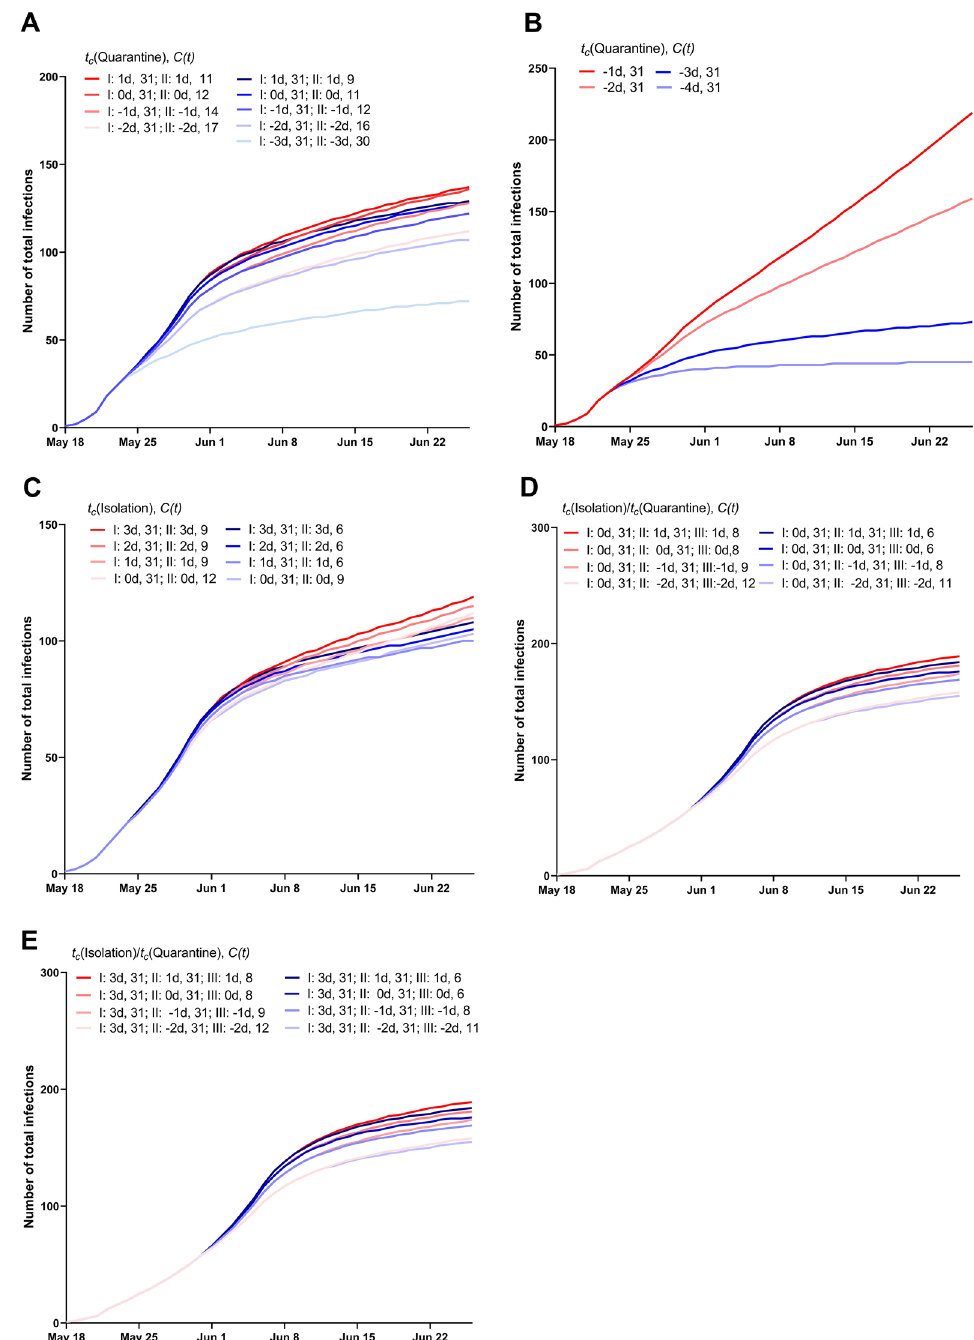
Figure 6. Estimation of effectiveness of the four strategies. ( A ) Strategy 1: initial quarantine/isolation followed by social distancing, including two phases. The first phase is from May 21 to May 28: t c (Quarantine) = − 4d, − 3d, − 2d, − 1d, 0d, 1d, C(T) = 31; The second phase is from May 28 to June 26: t c (Quarantine) = − 4d, − 3d, − 2d, − 1d, 0d, 1d, C(T) = 31*(5–95%); ( B ) Strategy 2: quarantine/isolation only from May 21 to June 26: t c (Quarantine) = − 4d, − 3d, − 2d, − 1d, 0d, 1d, C(T) = 31; ( C ) Strategy 3: initial isolation followed by social distancing, including two phases. The first phase is from May 21 to May 28: t c (Isolation) = 0d, 1d, 2d, 3d, C(T) = 31; The second phase is from May 28 to June 26: t c (Isolation) = 0d, 1d, 2d, 3d, C(T) = 31*(5–95%); ( D ) Strategy 4: initial isolation followed by quarantine and social distancing. The isolation was initially implemented the same day of symptom onset, including three phases. The first phase is from May 21 to May 28: t c (Isolation) = 0d, C(T) = 31; The second phase is from May 28 to June 5: t c (Quarantine) = − 4d, − 3d, − 2d, − 1d, 0d, 1d, C(T) = 31; The third phase is from June 5 to June 26: t c (Quarantine) = − 4d, − 3d, − 2d, − 1d, 0d, 1d, C(T) = 31*(5–95%); ( E ) Strategy 4: initial isolation followed by quarantine and social distancing. The isolation was initially imposed on average 3 days after symptom onset, including three phases. The first phase is from May 21 to May 28: t c (Isolation) = 3d, C(T) = 31; The second phase is from May 28 to June 5: t c (Quarantine) = − 4d, − 3d, − 2d, − 1d, 0d, 1d, C(T) = 31; The third phase is from June 5 to June 26: